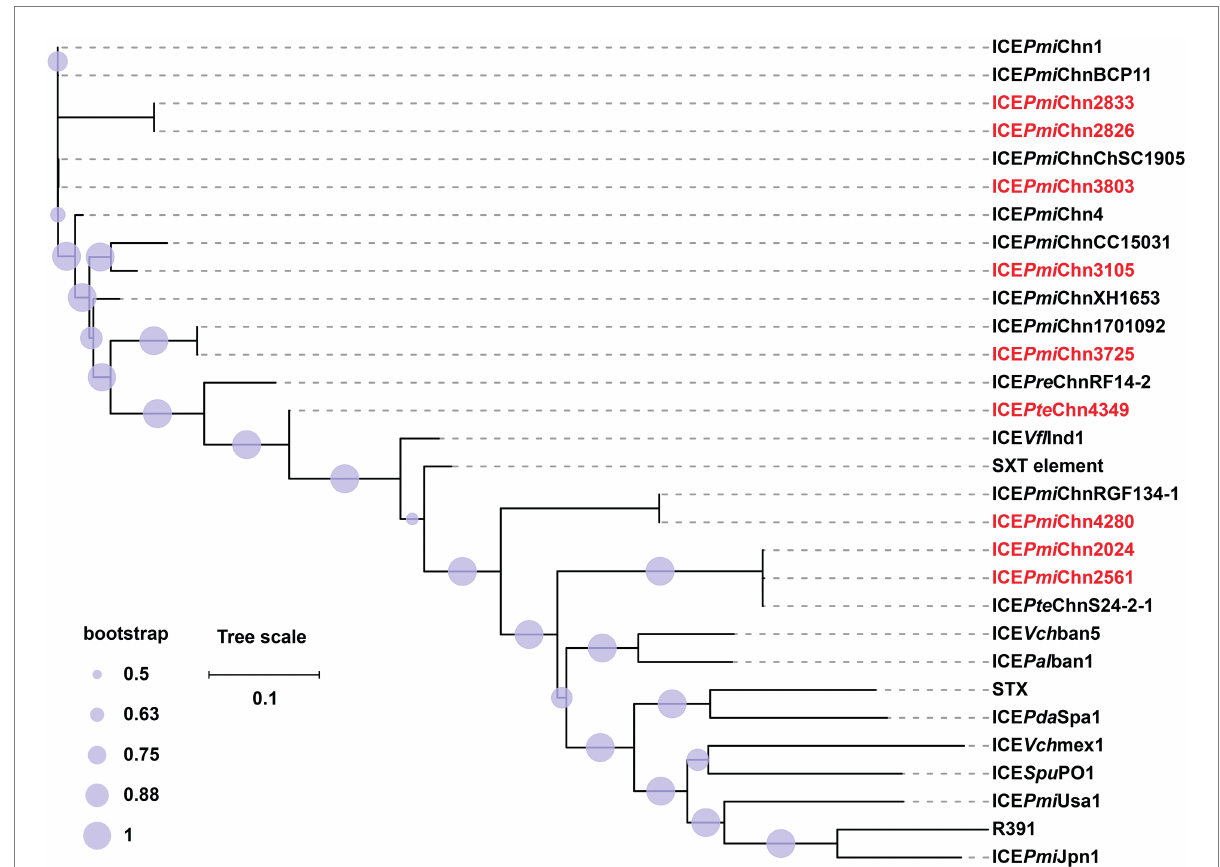
FIGURE 4 Phylogenetic analysis of ICEs in this study and 21 representative SXT/R391 ICEs. The phylogenetic tree of ICEs was constructed based on the SNPs in their conserved regions with the maximum-likelihood method in FastTree. ICEs in this study are highlighted in red. The tree scale indicates substitutions per site. Detailed information of these ICEs is presented in Supplementary Table